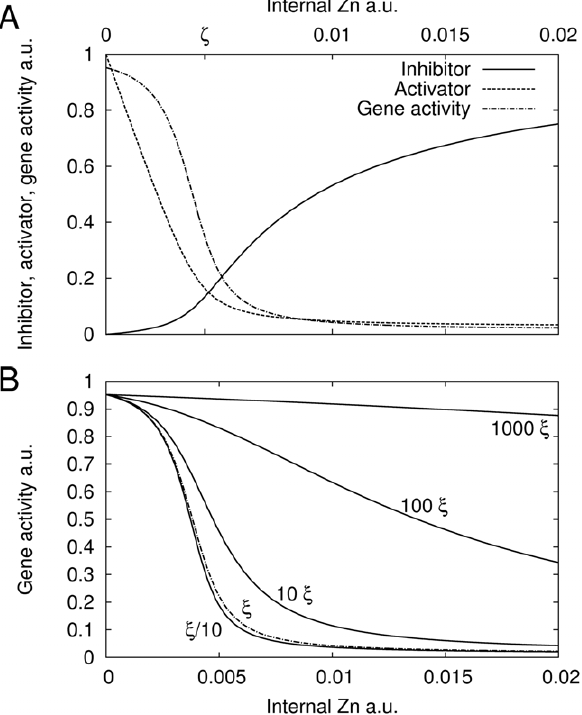
Figure 6. Plant roots: Activator-Inhibitor model with dimeriza- tion. A, steady state values of inhibitor (solid), activator (dashed) and gene activity (dash-dotted) in dependence of internal zinc concentra- tion. B, steady state gene activity in dependence of internal zinc status for varying j . Dashed curve corresponds to the nominal j ~ 10 { 3 .